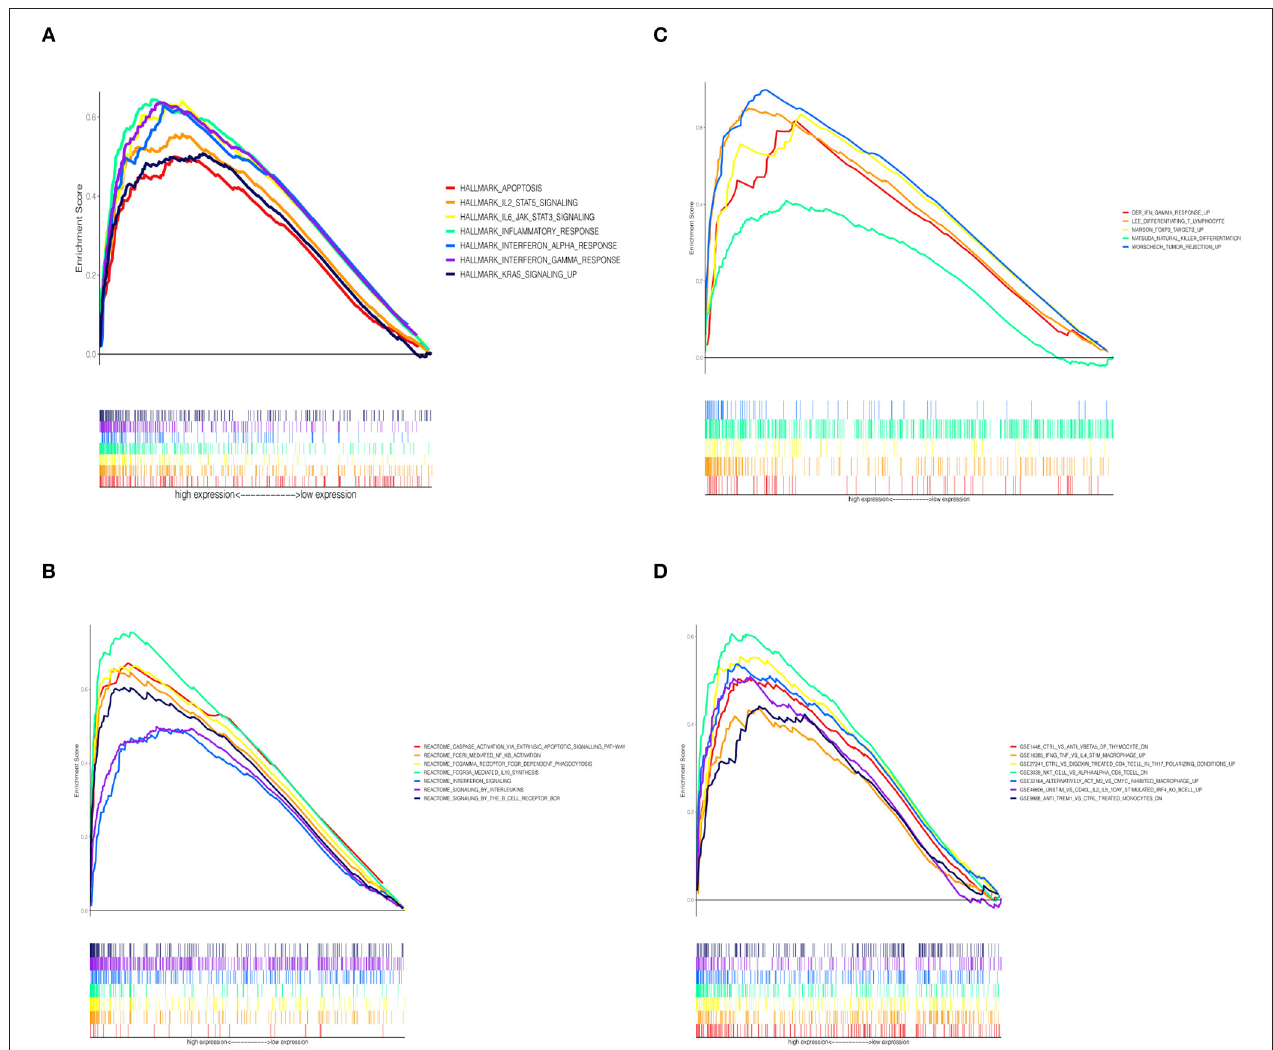
FIGURE 5 | (A) Enriched gene sets in the HALLMARK collection in samples with high CCL5 expression. (B) Enriched gene sets in REACTOME Pathways databases in samples with high CCL5 expression. (C) Enriched gene sets in Canonical Pathways gene sets in samples with high CCL5 expression. (D) Enriched gene sets in C7 immune gene sets in samples with high CCL5